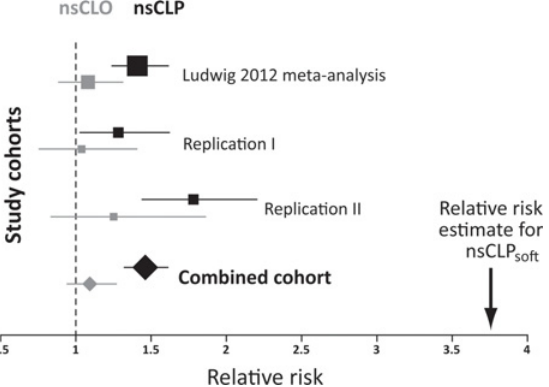
Fig 3. Forest plot for association of rs1258763 and nsCL/P subphenotypes. Subphenotype analyses of cleft lip and palate (nsCLP, black) and cleft lip only (nsCLO, grey) were conducted in the Ludwig 2012 meta- analysis data, the replication I and II cohorts, and in the combined analysis of the present study. Boxes represent point estimates of the relative risk for each of the four studies, with box sizes scaled according to the number of affected individuals. Lines indicate the extent of the confidence interval. These data illustrate the consistent association between rs1258763 and nsCLP across the various studies, and the presence of a narrow effect size range in the combined cohort. Please note that confidence intervals for nsCLO are larger due to the lower number of nsCLO patients. Informed by the specific expression of Grem1 in lip and soft palate development in the mouse embryo (see below) we also analyzed the effect size of the particular soft palate subphenotype (nsCLP soft ). The arrow indicates the point estimate for rs1258763 and nsCLP soft